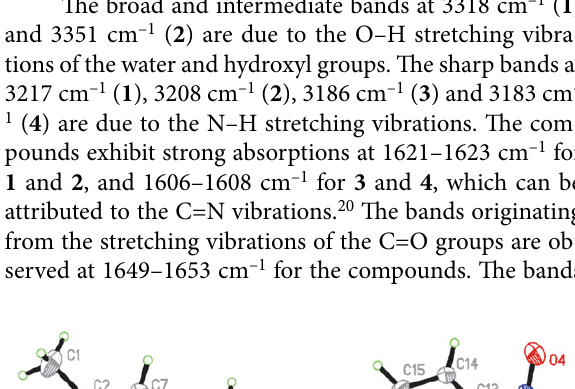
Figure 3. The packing diagram of 1 . Hydrogen bonding interac- tions are shown as dashed lines.